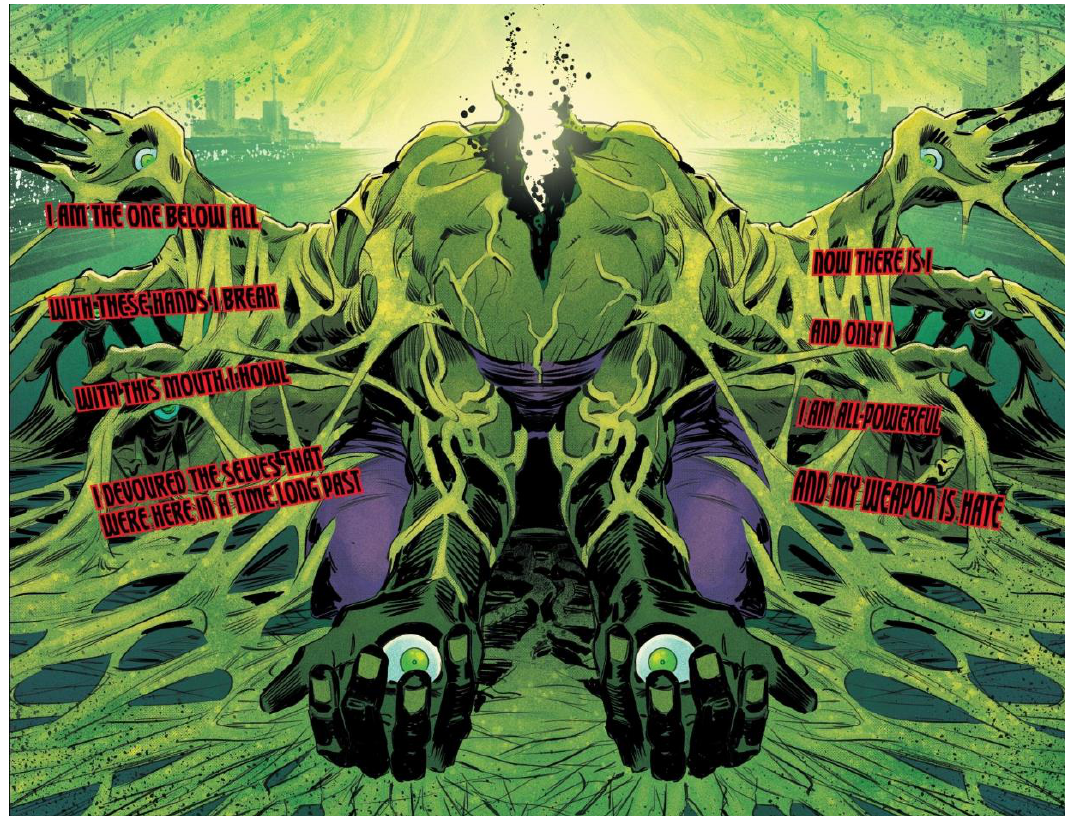
Figure 4. A headless Hulk in Immortal Hulk